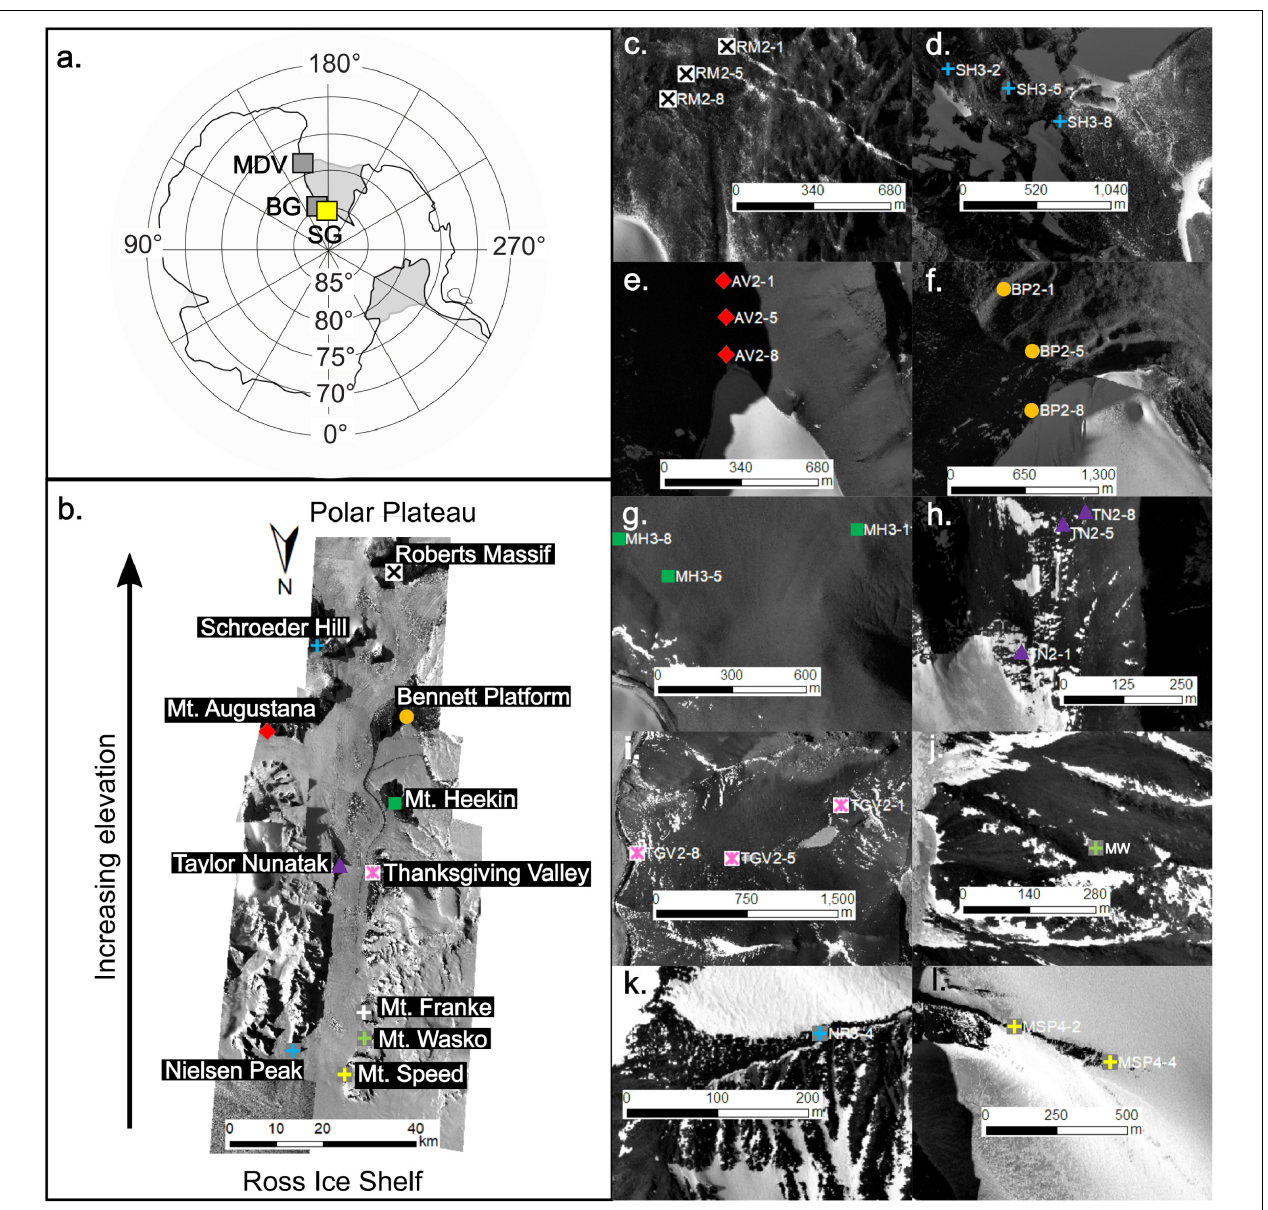
FIGURE 1 | Map of Antarctica highlighting the Shackleton Glacier (SG; yellow box) in relation to the McMurdo Dry Valleys (MDV) and Beardmore Glacier (BG) (gray boxes) (a) . The Shackleton Glacier is the focus of this study and flows from the Polar Plateau to the Ross Ice Shelf (b) . Soil samples were collected from 11 features along the glacier: Roberts Massif (c) , Schroeder Hill (d) , Mt. Augustana (e) , Bennett Platform (f) , Mt. Heekin (g) , Taylor Nunatak (h) , Thanksgiving Valley (i) , Mt. Wasko (j) , Nilsen Peak (k) , Mt. Speed (l) , and Mt. Franke (not shown). The symbols represent sampling locations, though no accurate GPS coordinate could be recorded from Mt. Wasko. Images of the Shackleton Glacier were acquired from the Polar Geospatial Center